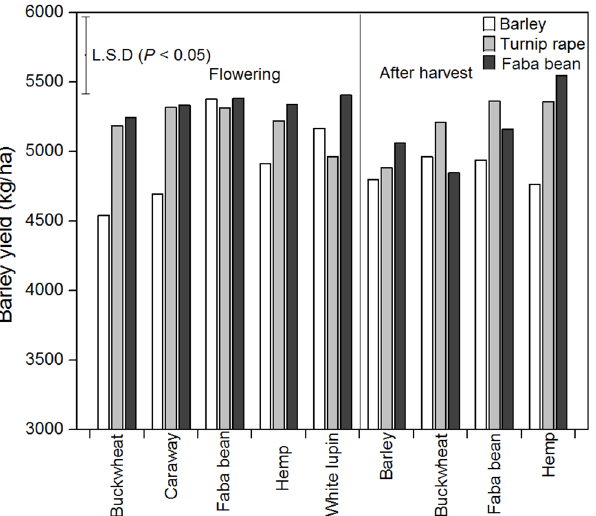
Fig 2. Yields of barley as affected by first crop, second crop and stage of incorporation of the second crop.